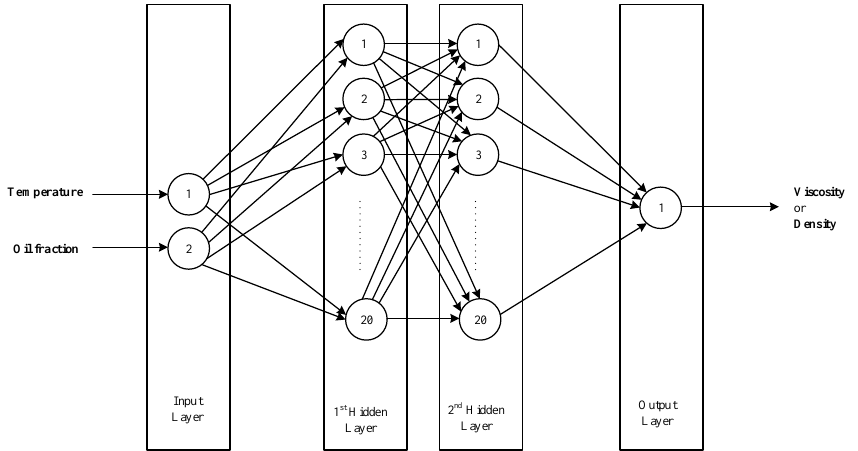
Fig. 1. ANN structure used in this